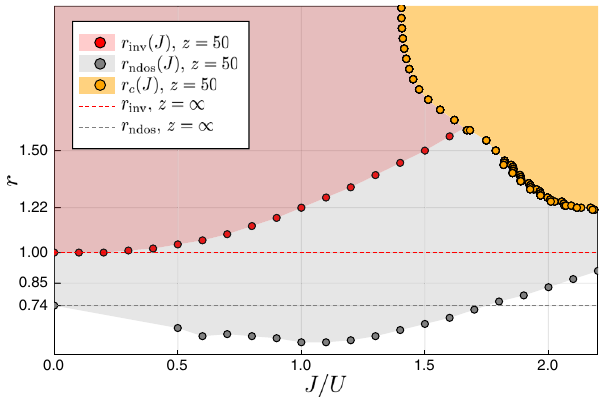
J Þ and for pop- FIG. 10. Threshold drives for NDOS r NDOS ð J Þ , as a function of the ulation inversion in the density matrix r inv ð J Þ (yellow hopping and compared with the critical drive r c ð points) for the finite-frequency superfluid transition. The ticks of the y axis correspond to the values of r used for Figs. 8 and 9. We see that for a small value of r the phase transition occurs even in the absence of a population inversion; i.e., it is the NDOS the key effect leading to the instability of the normal phase. Parameters: 10 and dim 14 . Gray curve: z ¼ 50 . Red curve: t H ¼ max ¼ 20 and dim 10 t H ¼ max ¼